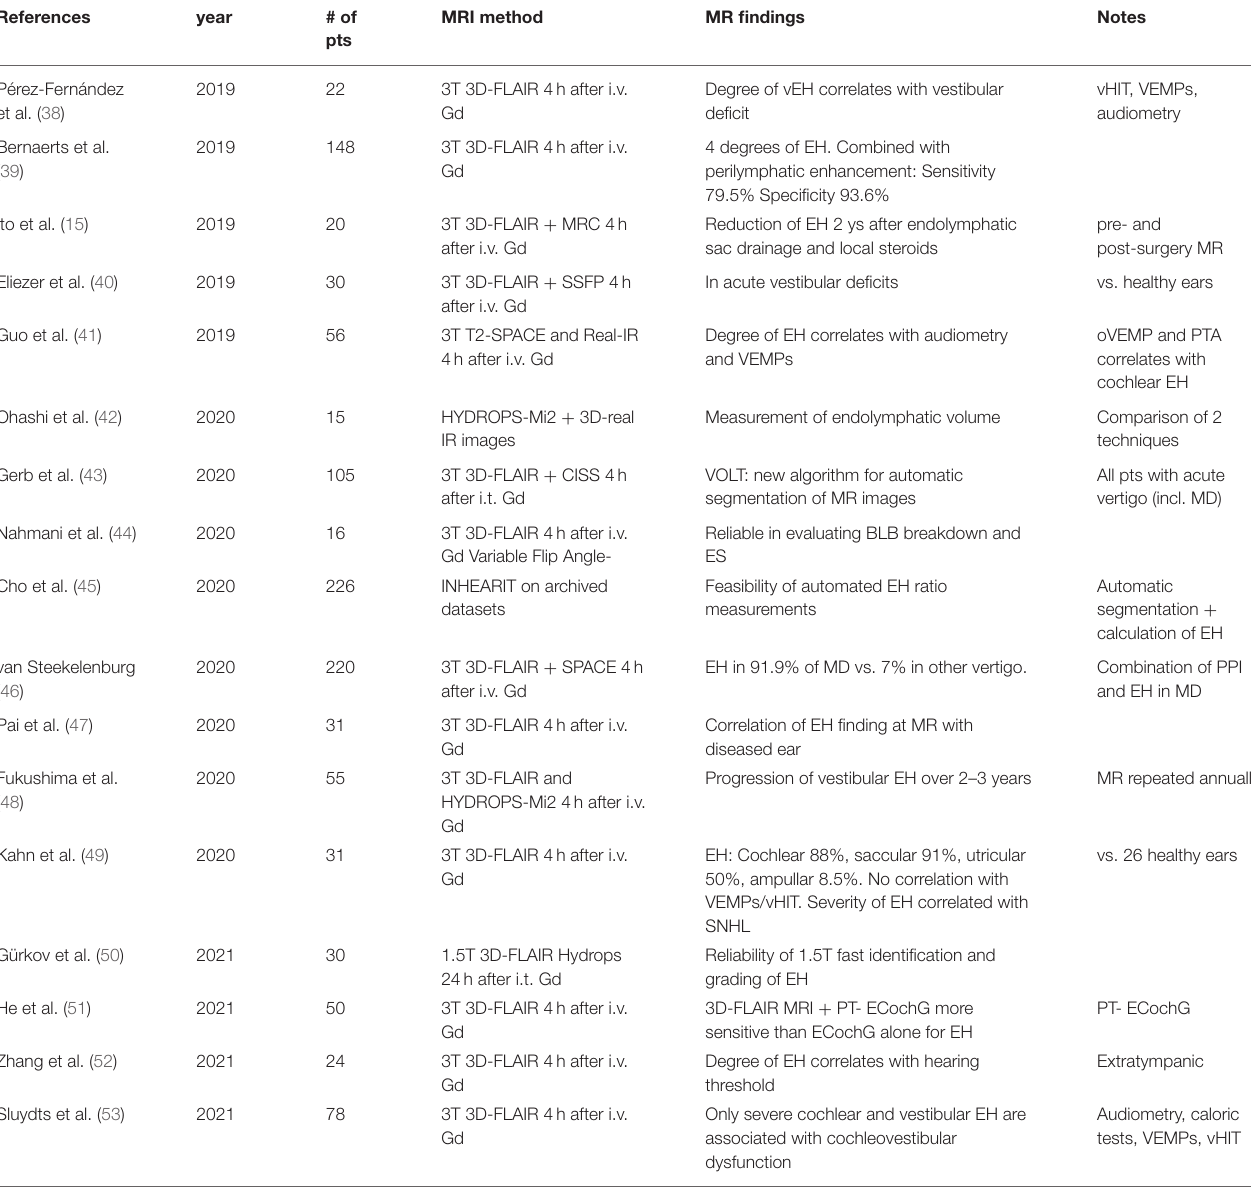
BLB, blood-labyrinth barrier; CISS, continuous Interference Steady-State; CNR, contrast-to-noise ratio; ECochG or TT-ECochG, trans-tympanic electro-cocleography; EH, endolymphatic hydrops; ES, endolymphatic space; FLAIR, Fluid Attenuated Inversion Recovery; hT2w-VISTA-IR, heavily T2-weighted volume isotropic turbo spin echo acquisition inversion recovery; HYDROPS, Hybrid of the reversed image of the positive endolymph signal and native image of positive perilymph signal; HYDROPS-Mi2, multiplication of HYDROPS with MRC; INEARHIT, Inner Ear Hydrops Estimation via Artificial Intelligence; MIIRMR, medium inversion time inversion recovery imaging with magnitude reconstruction; MIP, maximum intensity projections; IR-TSE, Inversion Recovery Turbo Spin-Echo; MRC, magnetic resonance cisternography; PEI, positive endolymph image; PPI, positive perilymph image; PS, perilympahtic space; PT- ECochG, peri-tympanic electro-cocleography; RPV, Recurrent peripheral vestibulopathy; SNHL, sensorineural hearing loss; SPACE, sampling perfection with application-optimizedcontrastsbyusingdifferentflipangleevolutions;SPAIR,SpectralAttenuatedInversionRecovery;SSFP,steady-statefreeprecessionsequences;SURI,Inversionof the saccule to utricle area ratio; 3D-REAL-IR, 3D-inversion-recovery turbo spin-echo with real reconstruction; VEMPs, vestibular-evoked myogenic potentials (oVEMPs: ocular, cVEMPS: cervical); VESCO, vestibular endolymphatic space contacting the oval window; VHIT, video Head Impulse Test; VNG, video-nystagmography; VN, vestibular neuritis.